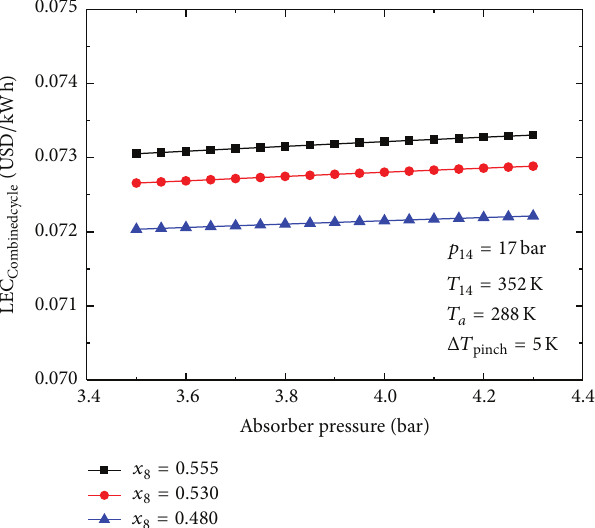
Figure 4: Variation of LEC of combined cycle with absorber